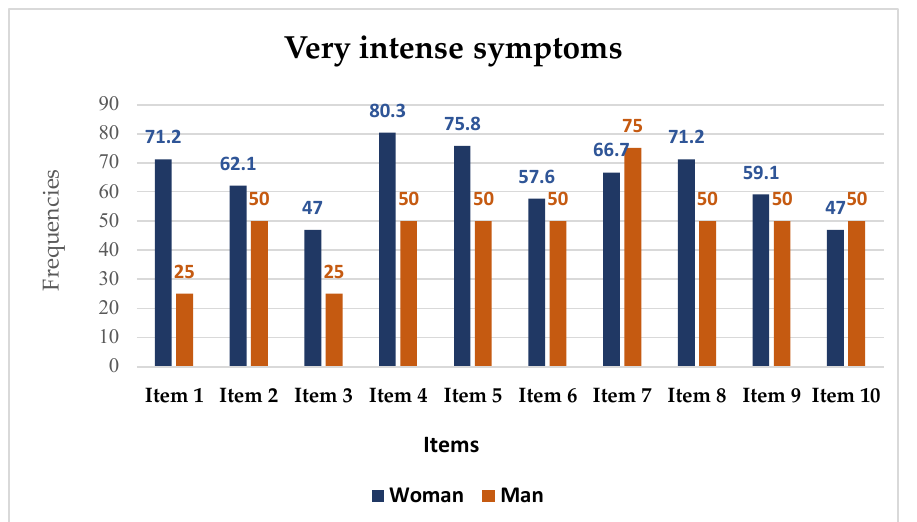
Figure 3. Frequency of very intense symptoms.